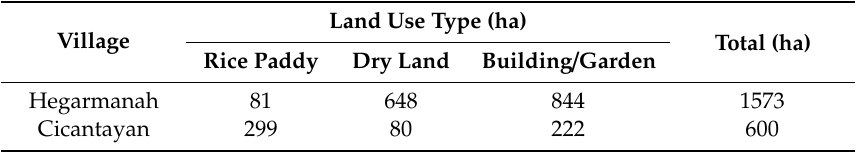
Table 2. Land use type and size of the Hegarmanah village and Cicantayan